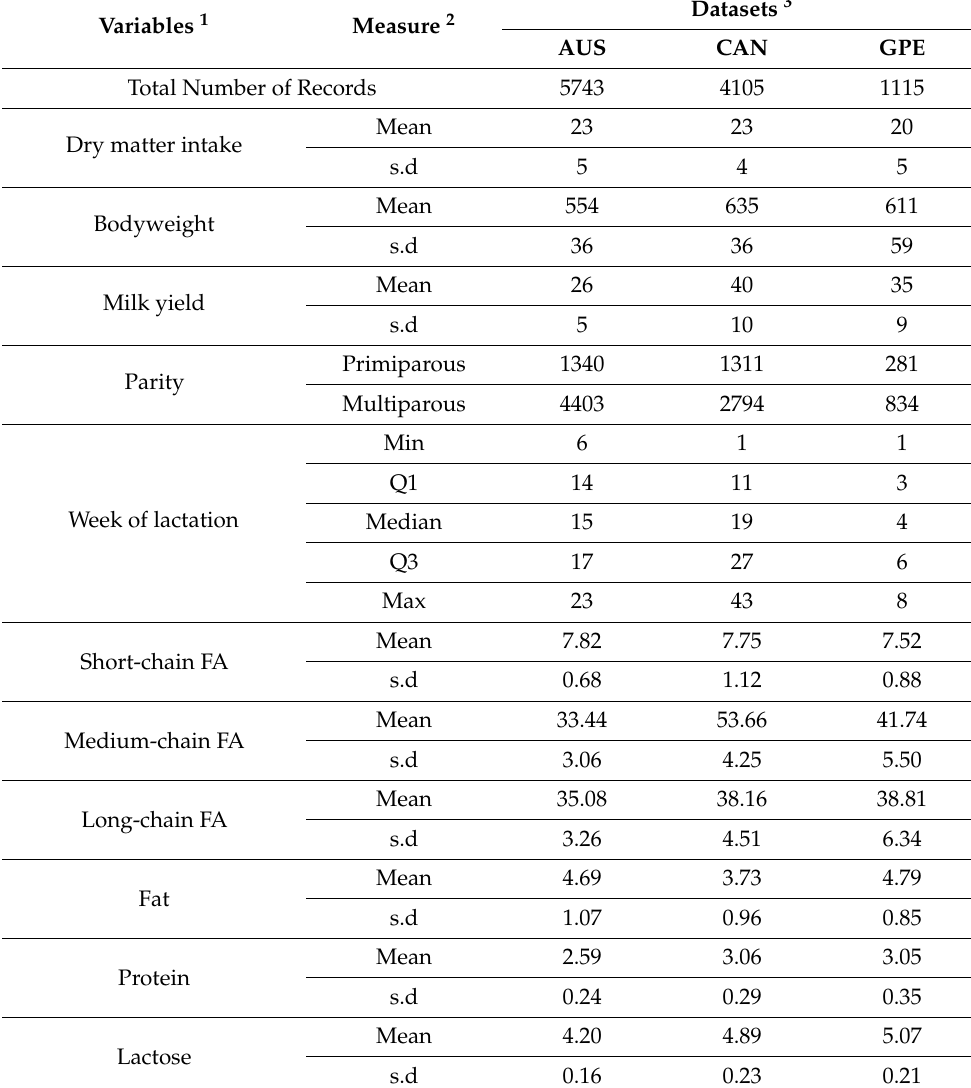
Table A1. Descriptive statistics of the original